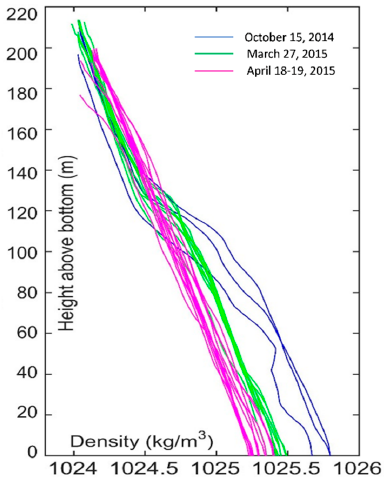
Figure 12. Density profiles as measured by CTD casts during the three periods.